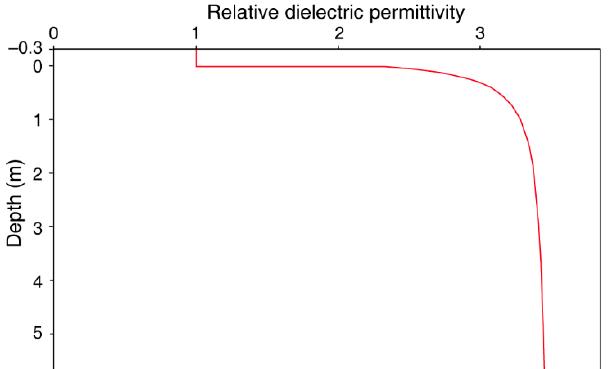
Figure 1. The 1D background model of relative dielectric permittivity of the lunar regolith. There is a 0.3 m vacuum layer between the radar antennas and the lunar surface.